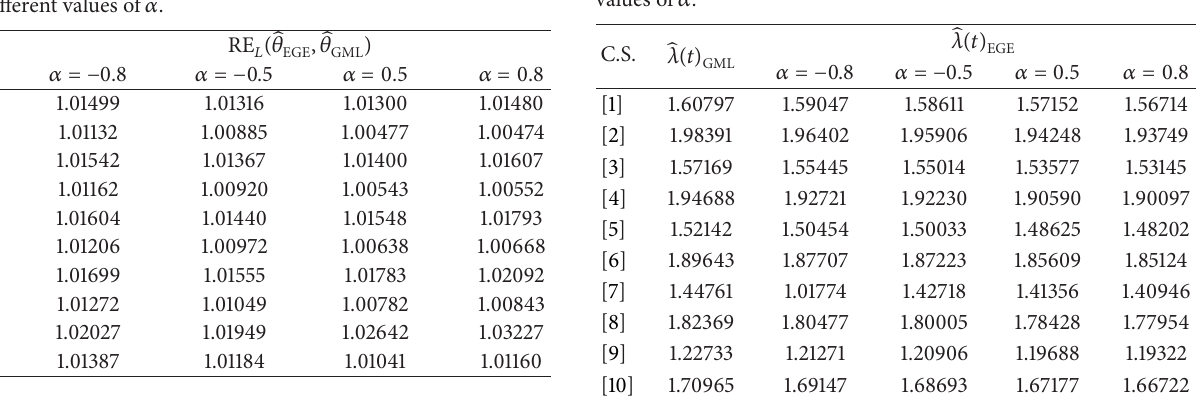
̂𝜃 ̂𝜃 with respect to under GELF EGE GML